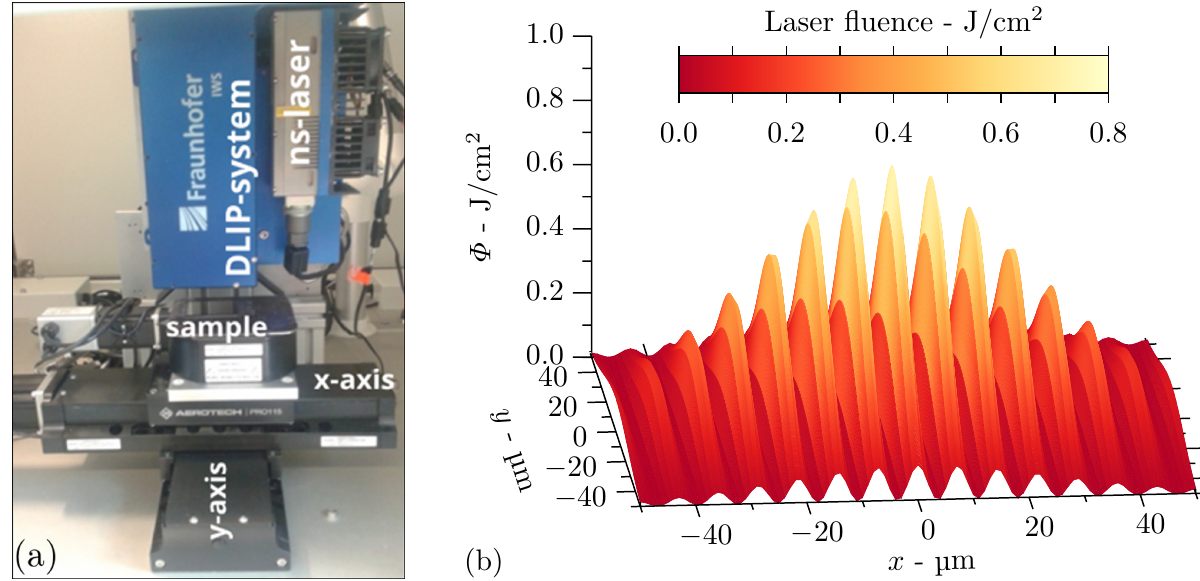
Figure 2. Setup employed for direct laser interference patterning (DLIP) experiments on steel substrates: ( a ) nanosecond pulsed infrared laser, optical head for DLIP on a z -stage, and sample mounted on an x - y positioning stage and ( b ) laser fluence distribution of interference pattern due to two coherent partial beams with a Gaussian intensity